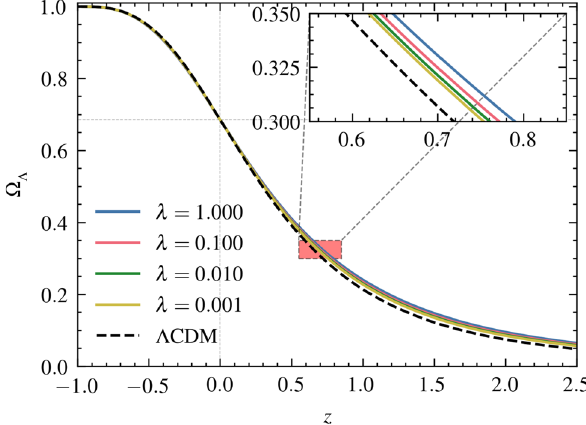
Fig. 9 Darkenergydensityparameter( (cid:12) (cid:2) )asafunctionofredshift( z ) for different values of λ (with (cid:12) m 0 = 0 . 315 and H 0 = 67 . 4